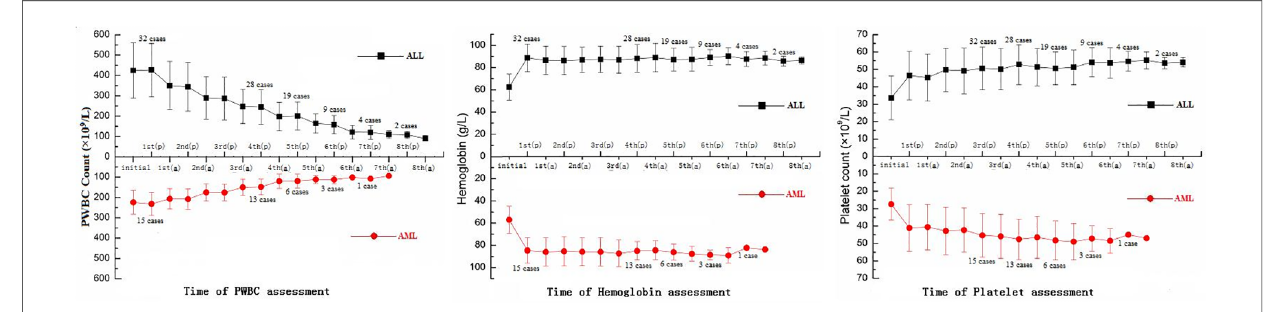
FIGURE 2 The total number of 47 patients with PWBC count, hemoglobin, and platelet count, including 32 ALL and 15 AML patients. (p), prior to the process; (a), after the process; PWBC, peripheral white blood cell; ALL, acute lymphocytic leukemia; AML, acute myeloblastic